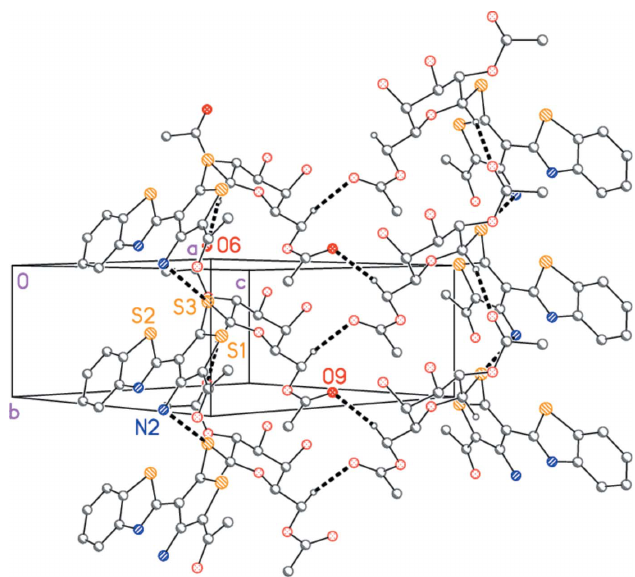
Figure 3 Crystal packing of 3 viewed perpendicular to (101) in the region x ’ 0.75, z ’ 0.25. For clarity, the following atoms/groups have been omitted: Hydrogen atoms not involved in ‘weak’ hydrogen bonding; two acetyl groups; the bromophenyl groups (except the ipso carbon atom). Dashed lines indicate hydrogen bonds or N (cid:3)(cid:3)(cid:3) S